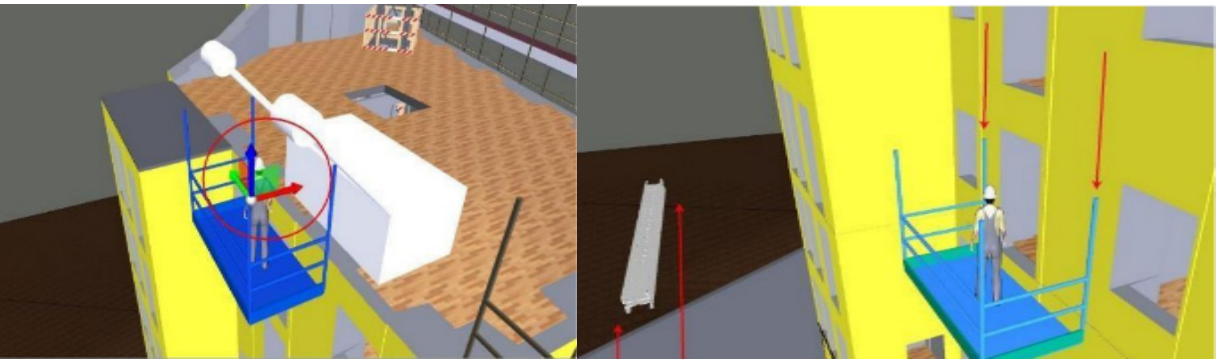
Figure 21. Simulation of hazard by crushing and suggestion of a steel beam movement.